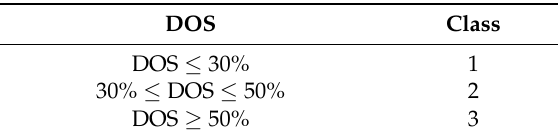
Figure 3. Measurement area of the degree of stenosis (DOS) component with respect to the B-mode ultrasound image. Table 1. Class partition based on